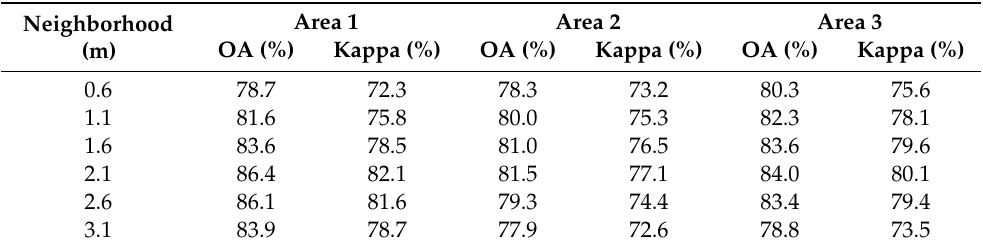
Overall accuracies and Kappa statistics with di ff erent neighbourhood size in three Vaihingen